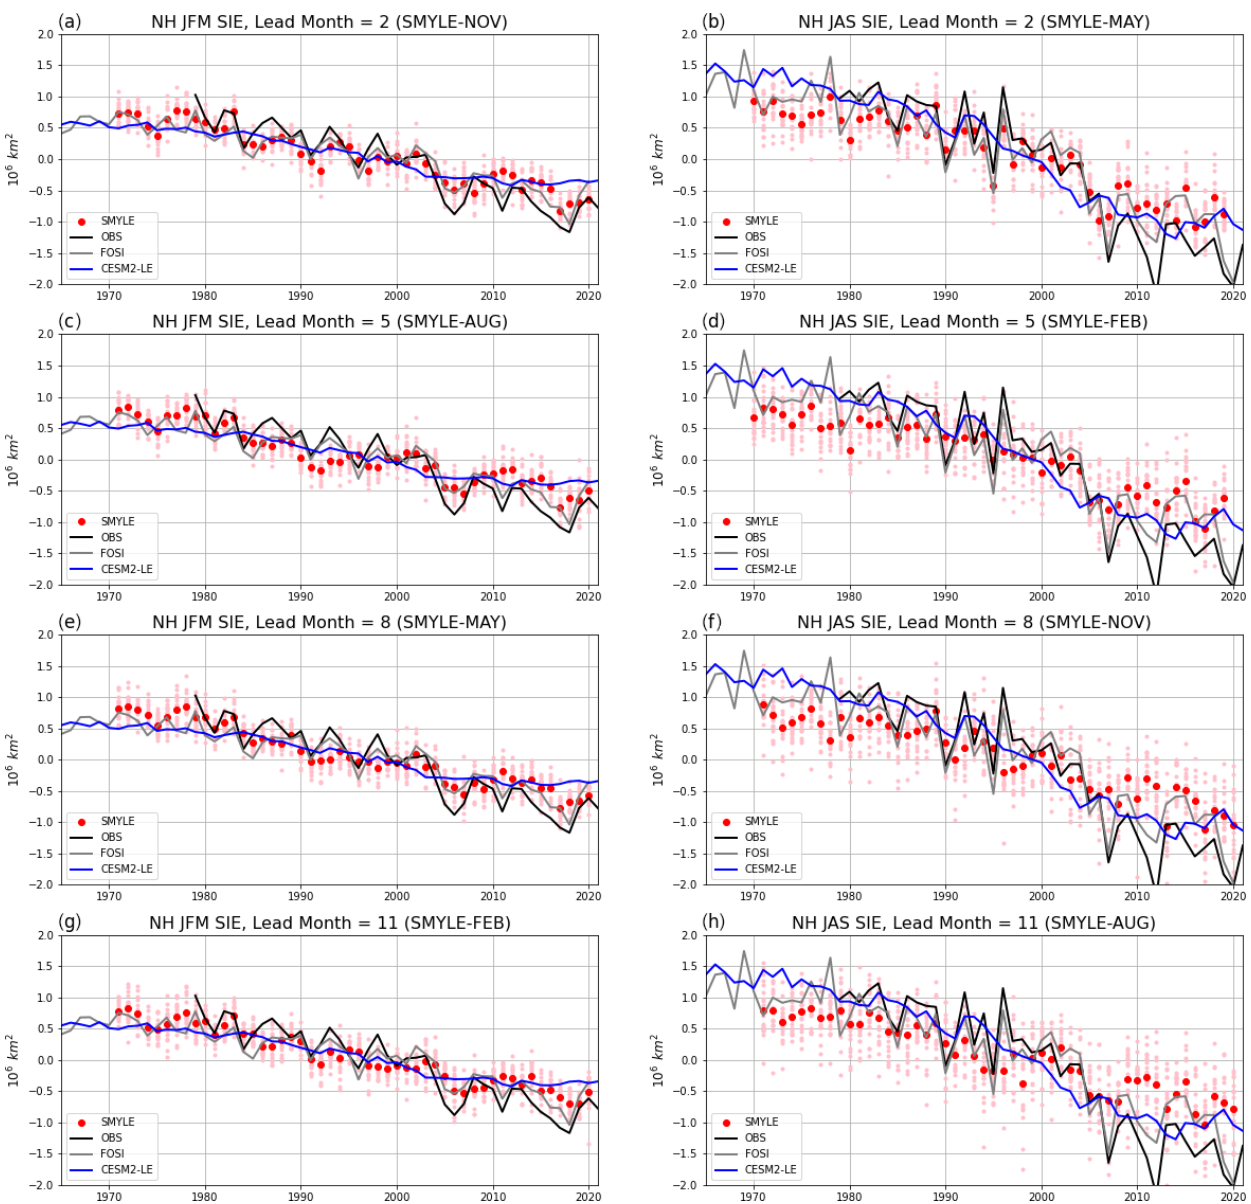
Figure 12. Northern Hemisphere seasonal sea ice extent (SIE) anomalies (relative to 1980–2015 climatology) for JFM (a, c, e, g) and JAS (b, d, f, h) from SMYLE (red and pink dots show ensemble mean and individual members, respectively), satellite observations (black line; Fetterer et al., 2017), SMYLE-FOSI (grey line), and CESM2-LE (blue line; 50-member mean). Rows show results for lead months 2, 5, 8, and 11. Skill scores (correlation and normalized RMSE) are provided for SMYLE (red) and CESM2-LE (blue) relative to both observations and SMYLE-FOSI (scores in parentheses). All time series were detrended (over the window of overlap between SMYLE and the verification dataset) prior to computing skill